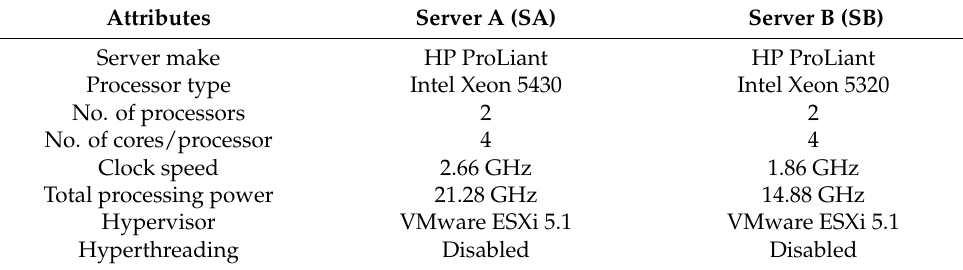
Table 2. Specification of servers.